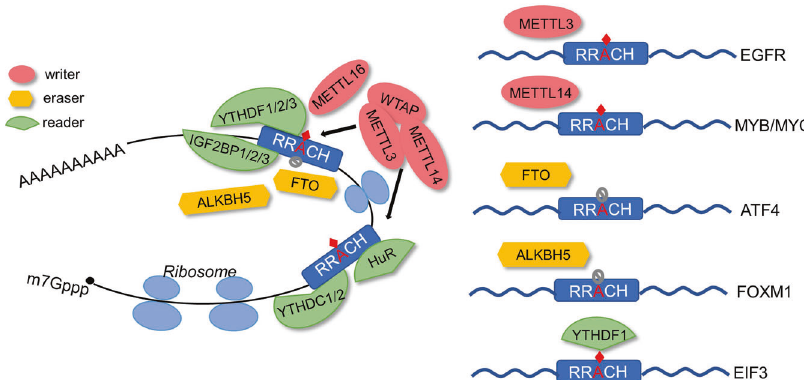
Fig. 3 m 6 A modi fi cation regulates protein translation. The m 6 A modi fi cation is catalyzed by the writers (METTL3/METTL14/WTAP, WETTL16) and demethylated by erasers (FTO, ALKBH5). The m 6 A modi fi cation is recognized by the readers (YTHDF1/2/3, YTHDC1/2, IGF2BP1/2/3, and HuR). The translation procedure of target genes can be in fl uenced by the m6A modi fi cation